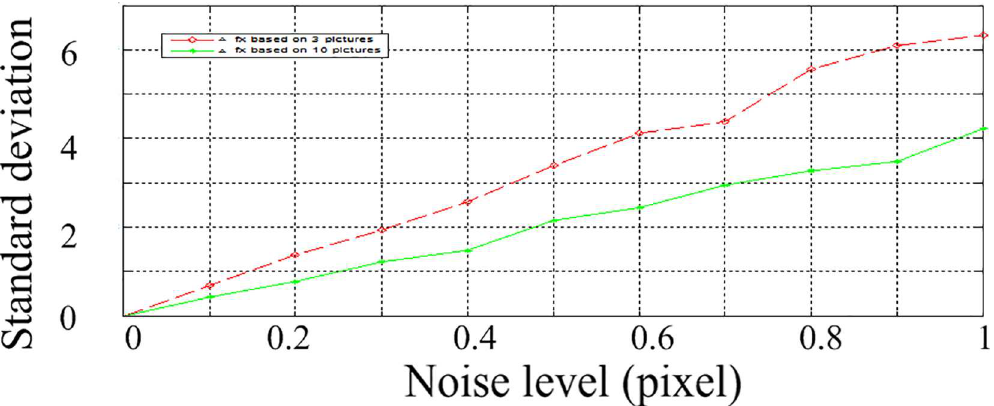
Fig 8. the standard deviations of f x with 3 and 10